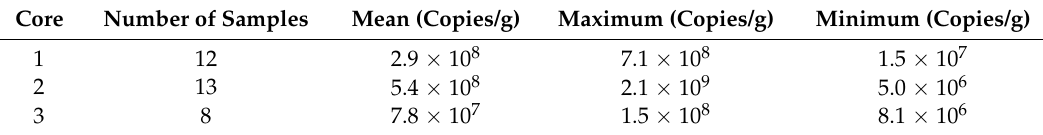
Table 3. 16S rRNA copy numbers in three